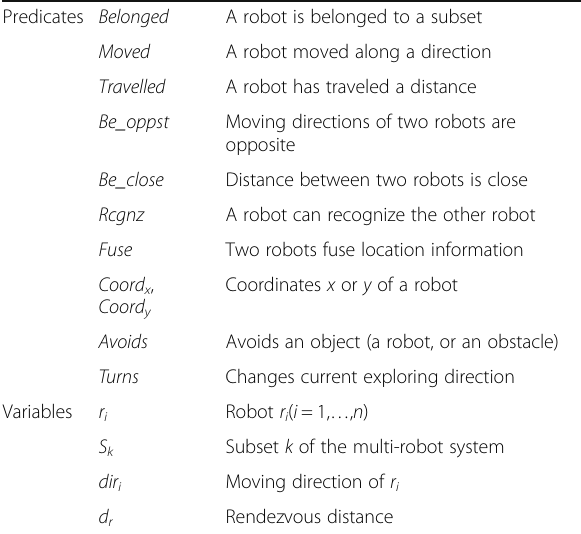
Table 1 Notations of predicate logic reasoning Predicates